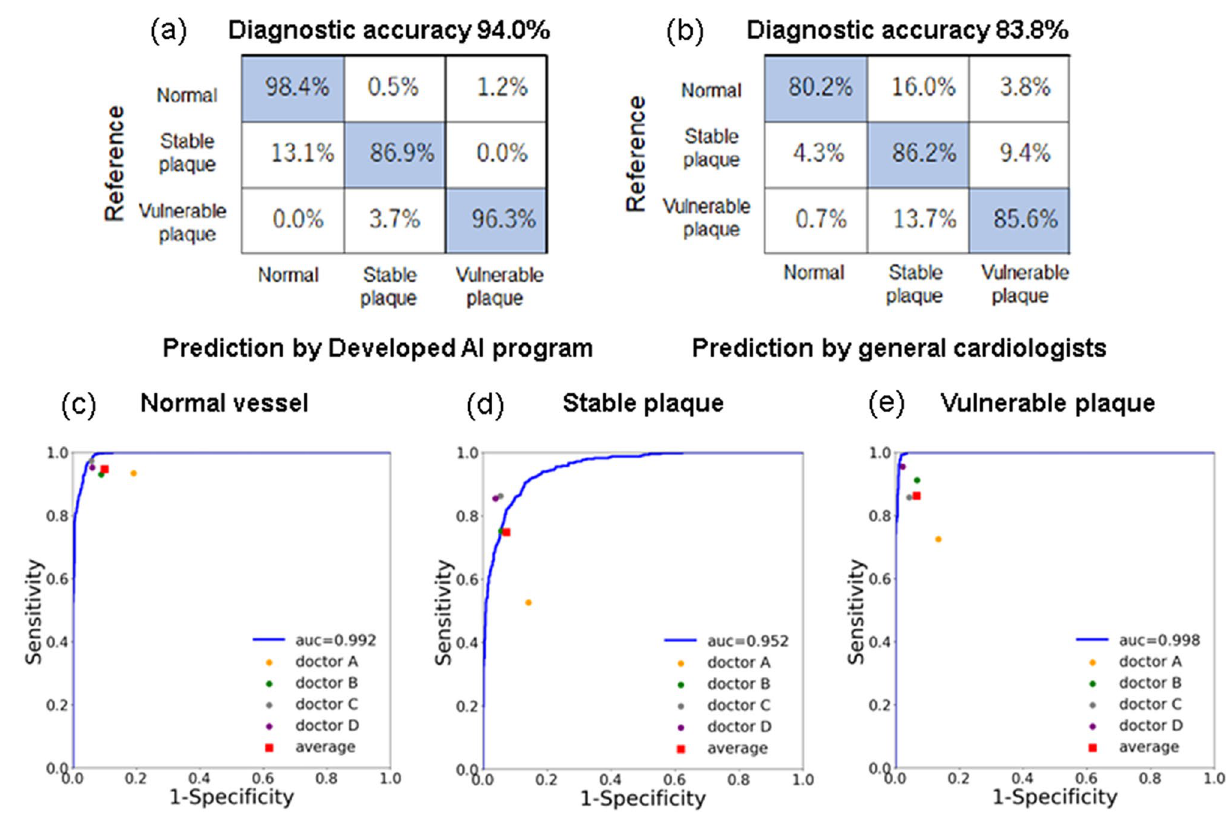
Figure 4. Diagnostic accuracy of the developed AI algorithm. Diagnostic accuracies of plaque vulnerability between the developed AI algorithm ( a ) and the general cardiologists ( b ) compared to the reference of the OCT- expert diagnosis. Receiver operating characteristic (ROC) curves for the AI algorithm for the differentiation of normal vessels ( c ), stable plaques ( d ), and vulnerable plaques ( e ). The dot plots represent the diagnostic accuracy of each general